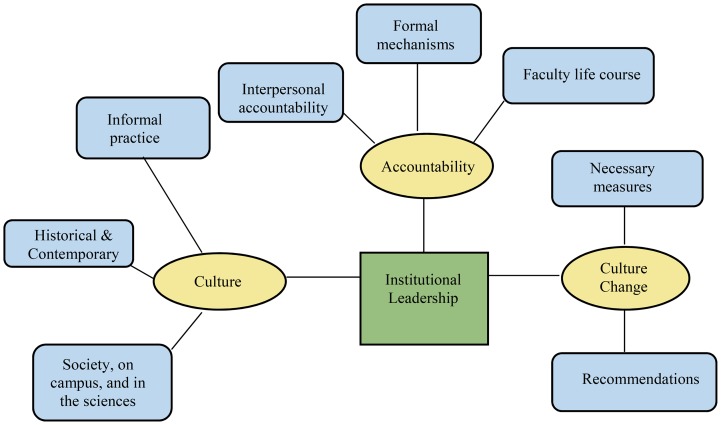
Thematic network.